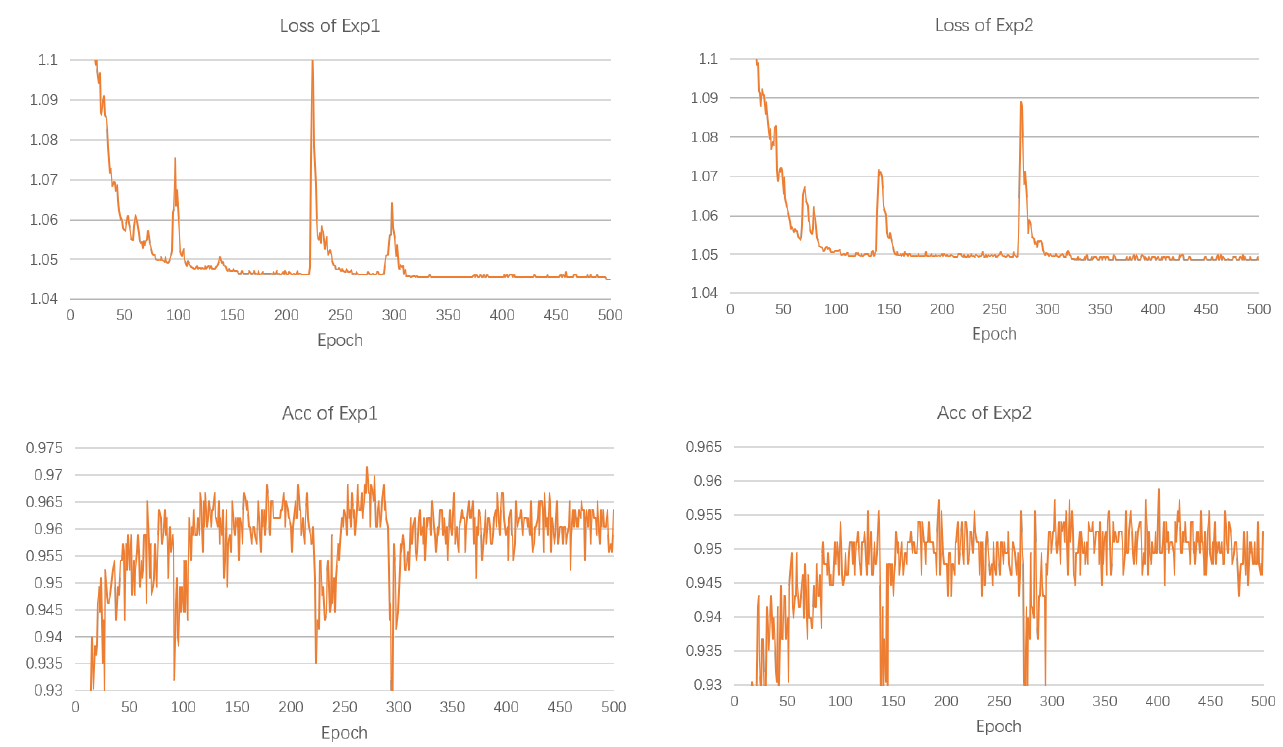
Figure 12. Loss and accuracy of the experiment.